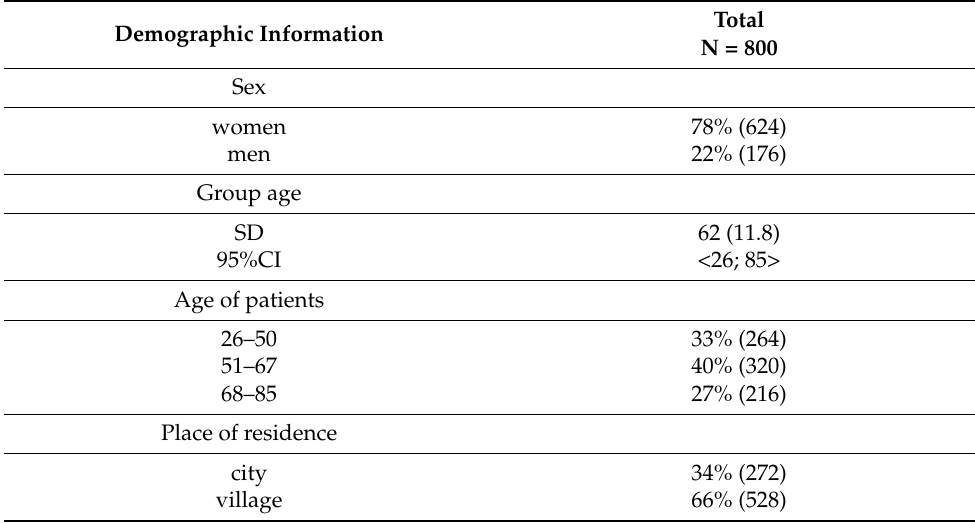
Table 1. Examined patients—descriptive